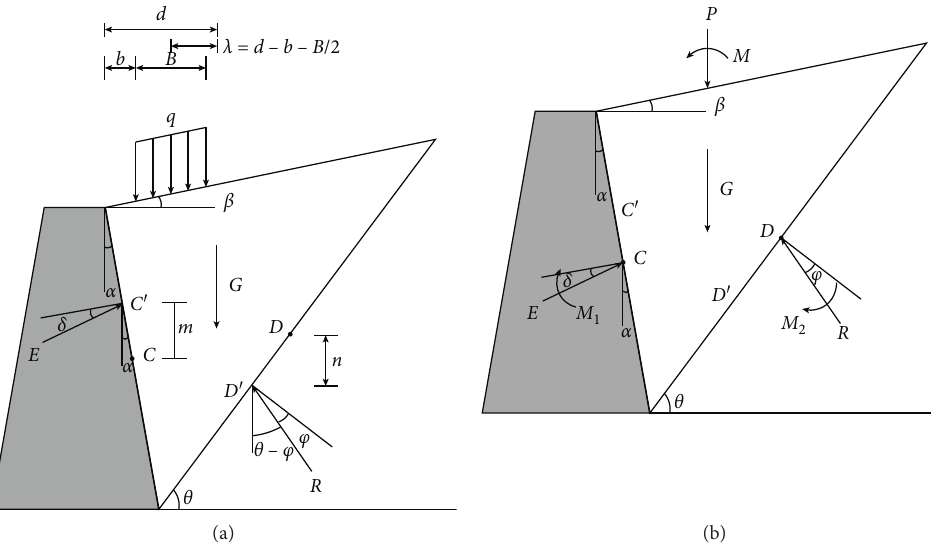
Figure 2: The midpoint of strip loading is on the left of the backfill gravity center. (a) Physical model. (b) Equivalent moment